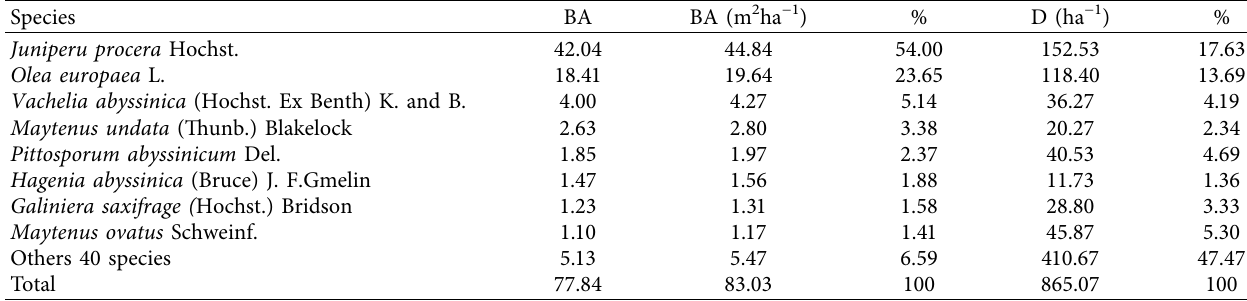
Table 4: Importance Value Index (IVI) of the top ten woody plant species of the study area. Species RD RF RDO Juniperus procera Hochst. Olea europaea L. Maytenus ovatus Schweinf. Pittosporum abyssinicum Del. Vachelia abyssinica (Hochst. Ex Benth) K. and B. Erica arborea L. Galiniera saxifrage (Hochst.) Bridson Maytenus undata Schweinf. Dombeyatorrida Dovyalis (J. F. Gmel) Bamps Urera hypselodenderon A. Rhi. Total